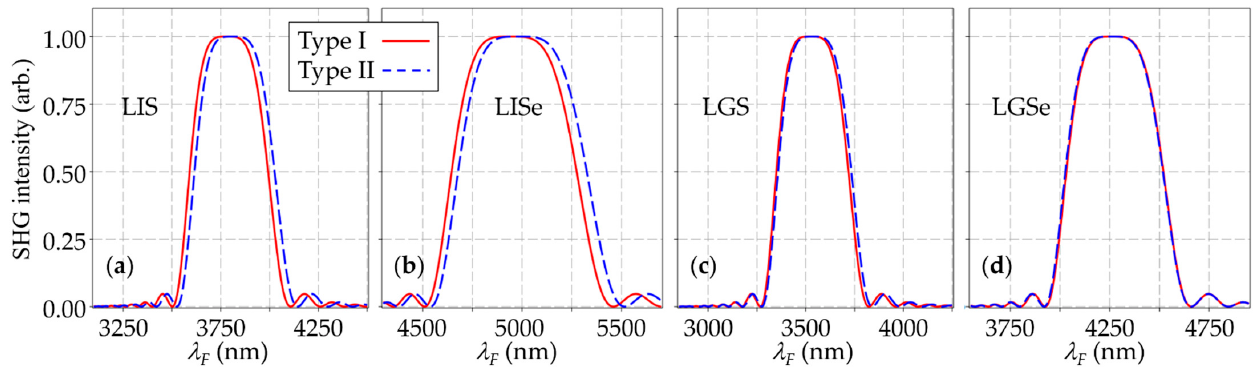
Figure 10. The spectra of F-waves that are acceptable for broadband SHG in biaxial mid-IR crystals: ( a ) LIS, ( b ) LISe, ( c ) LGS, and ( d ) LGSe. Solid red line: Type I; dashed blue line: Type II.